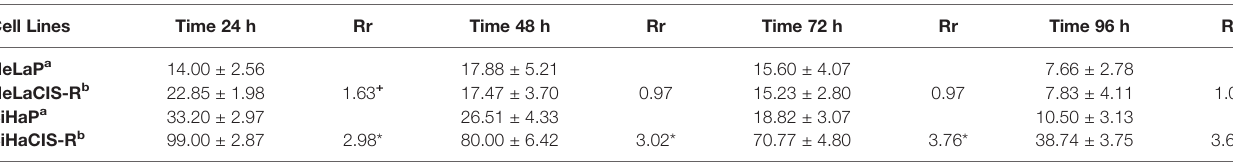
TABLE 2A | IC50 values for CIS (µM) in cervical cancer cells determined by the SRB assay. Cell Lines